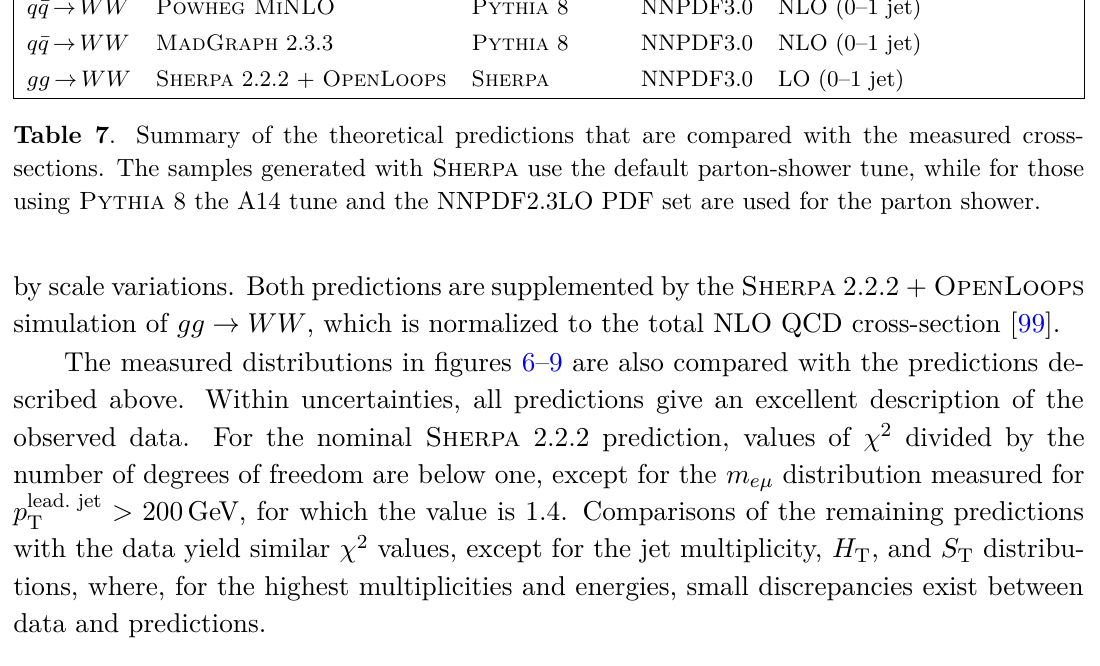
by scale variations. Both predictions are supplemented by the Sherpa 2.2.2 +